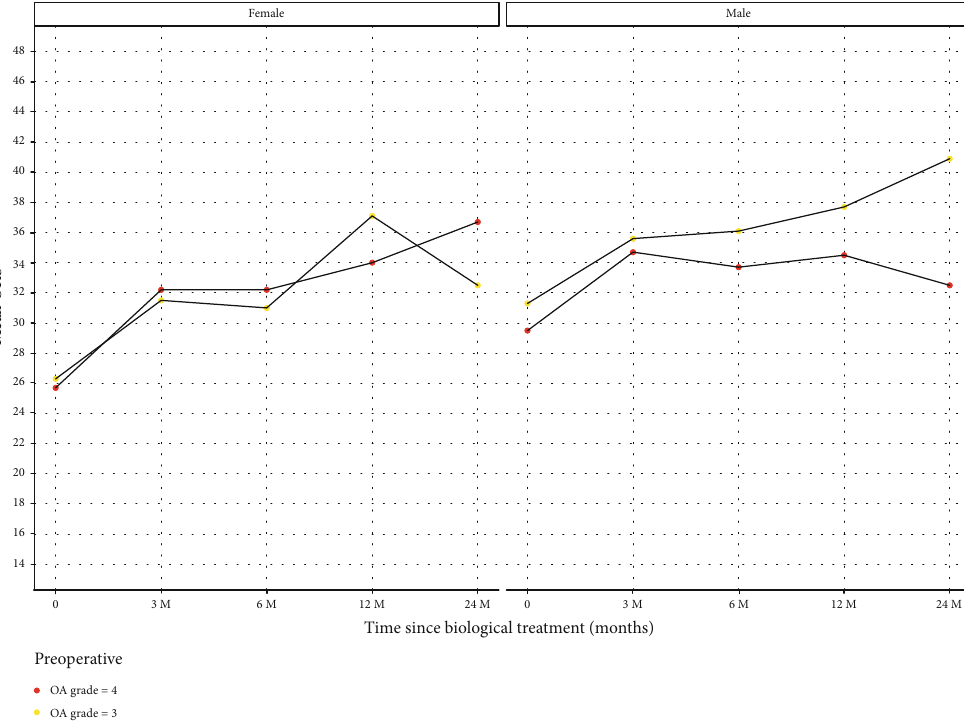
Figure 7: Patients grouped by KL OA grade at time of treatment (baseline) with follow-up OKS at 3, 6, 12, and 24 months. x -axis: time points in relation to treatment: baseline prior to treatment (0), 3, 6, 12, and 24 months posttreatment. y -axis: OKS mean for each group. Red (d1): KL OA grade 4 at time of treatment. Yellow (d2): KL OA grade 3 at time of treatment.